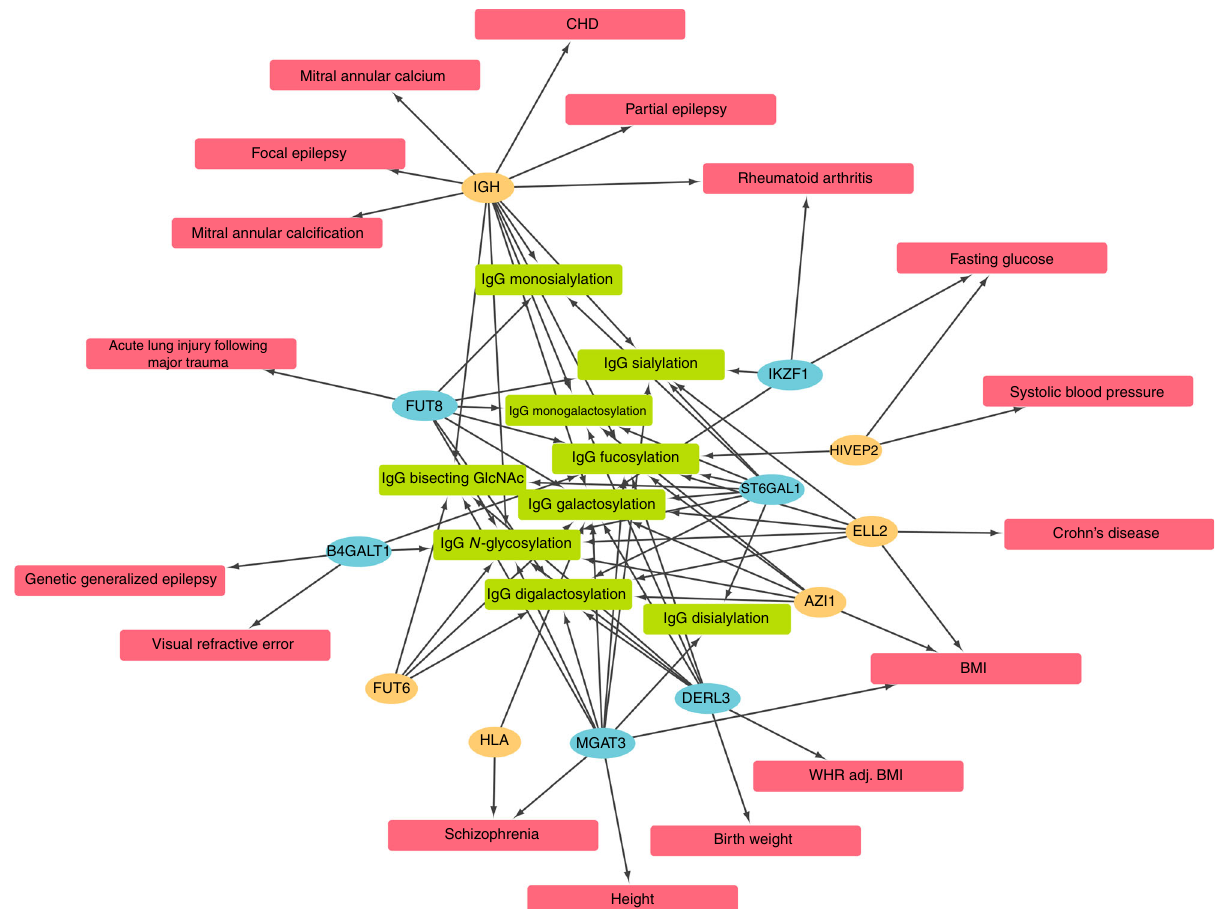
Fig. 4 Pleiotropic network of the novel ( orange ) and known ( blue ) loci discovered using the multivariate method. The IgG N -glycosylation phenotypes are shown in light green and complex traits/disease in red . The associations with complex traits were fi ltered based on an FDR cutoff of 5%. CAD, coronary heart disease; BMI, body mass index; WHR adj BMI, waist – hip ratio adjusted for